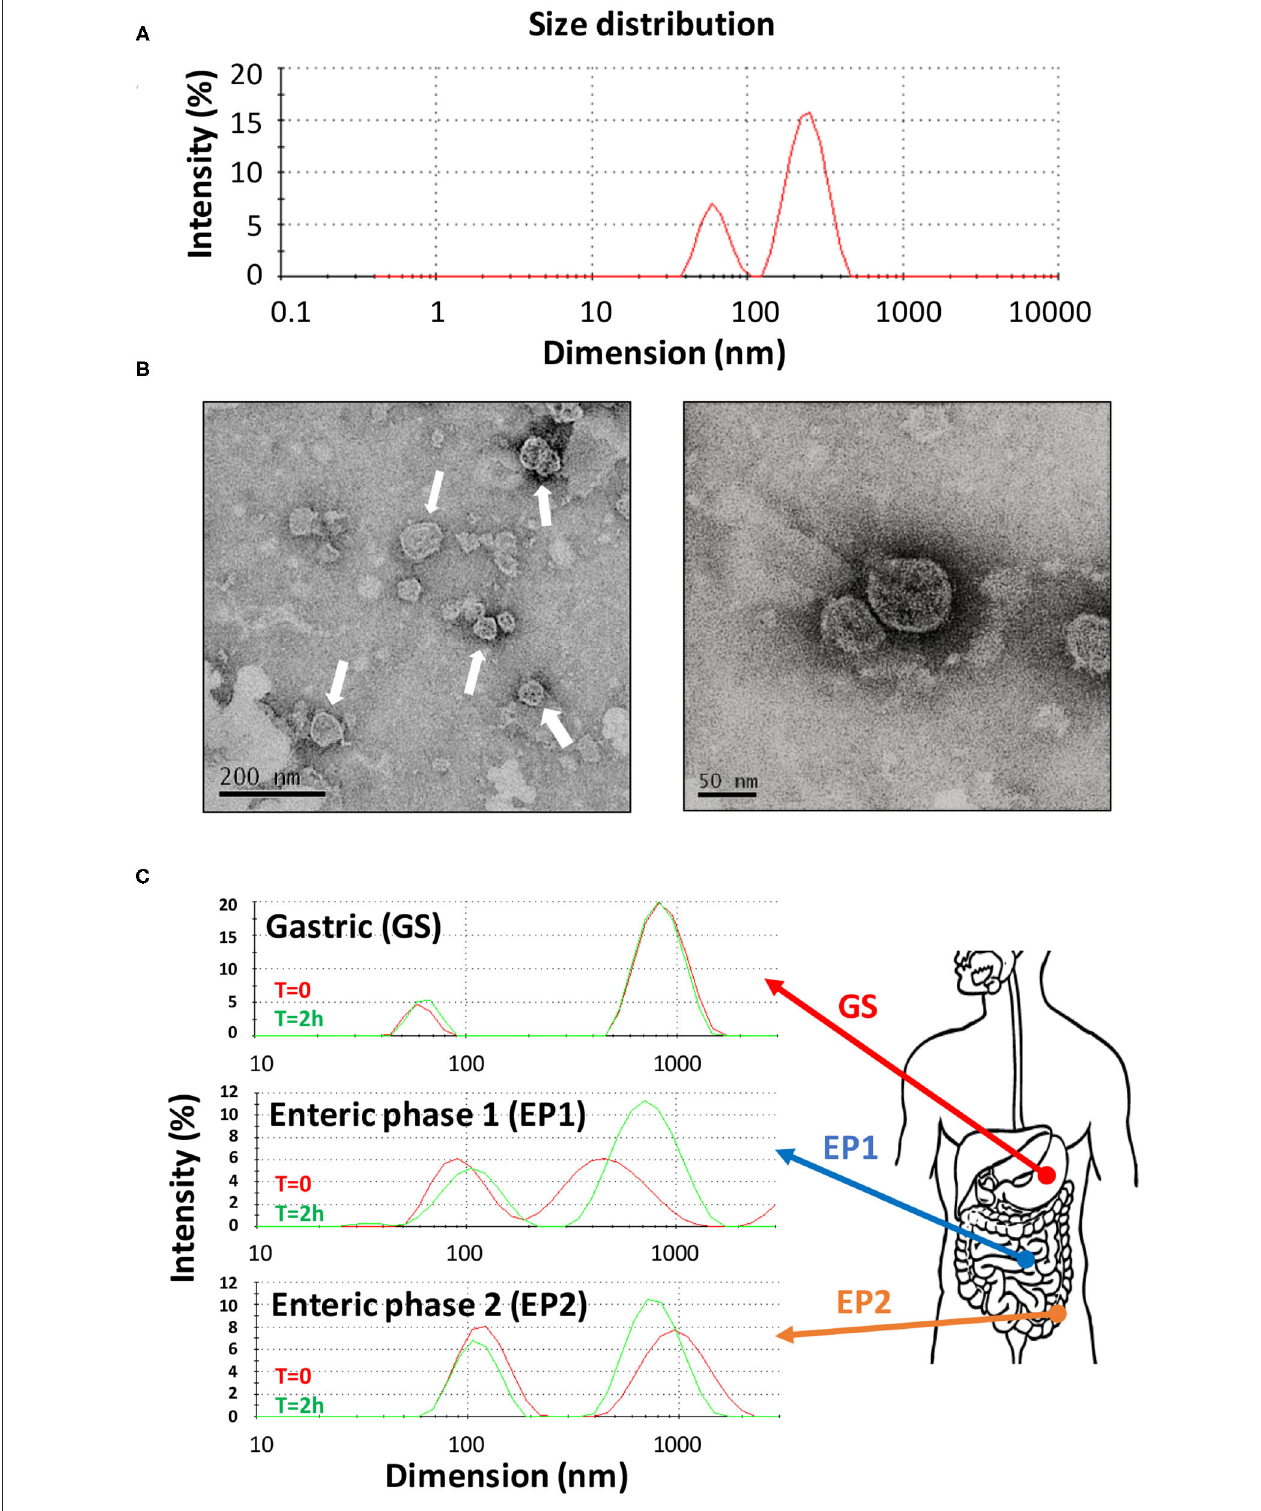
FIGURE 1 | Characterization of CS-EVs. Size distribution of CS-EVs in PBS (A) measured by DLS. TEM images of a preparation of CS-EVs (B) with a magnification of single vesicles. Simulated gastric solutions were employed to assess the stability of CS-EVs and mimic their behavior in the gastrointestinal tract (C) .